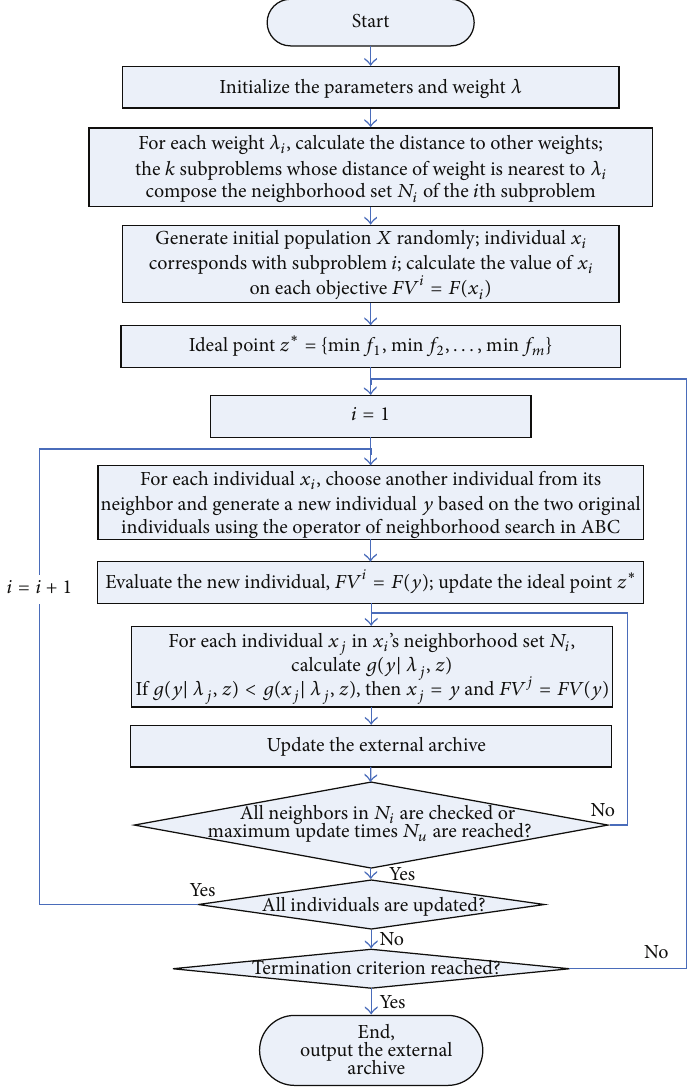
Figure 3: Flowchart of MOABC/D